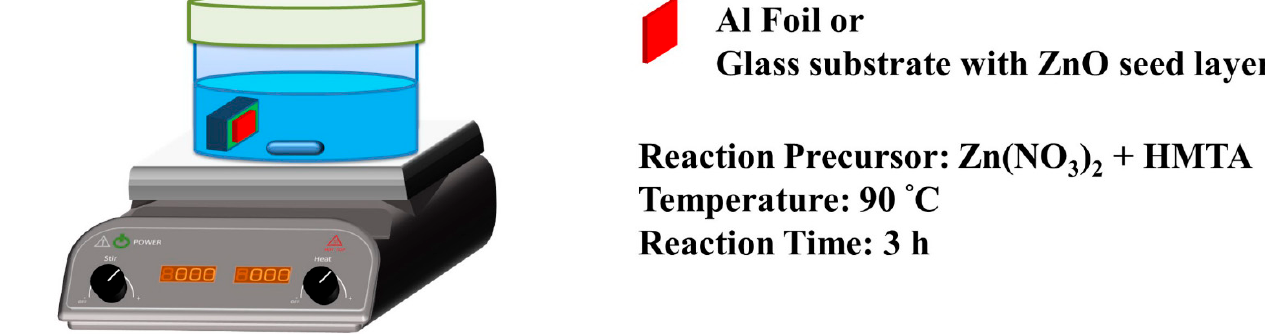
Figure 1. Schematic diagram of the reaction device for the growth of ZnO nanowalls.